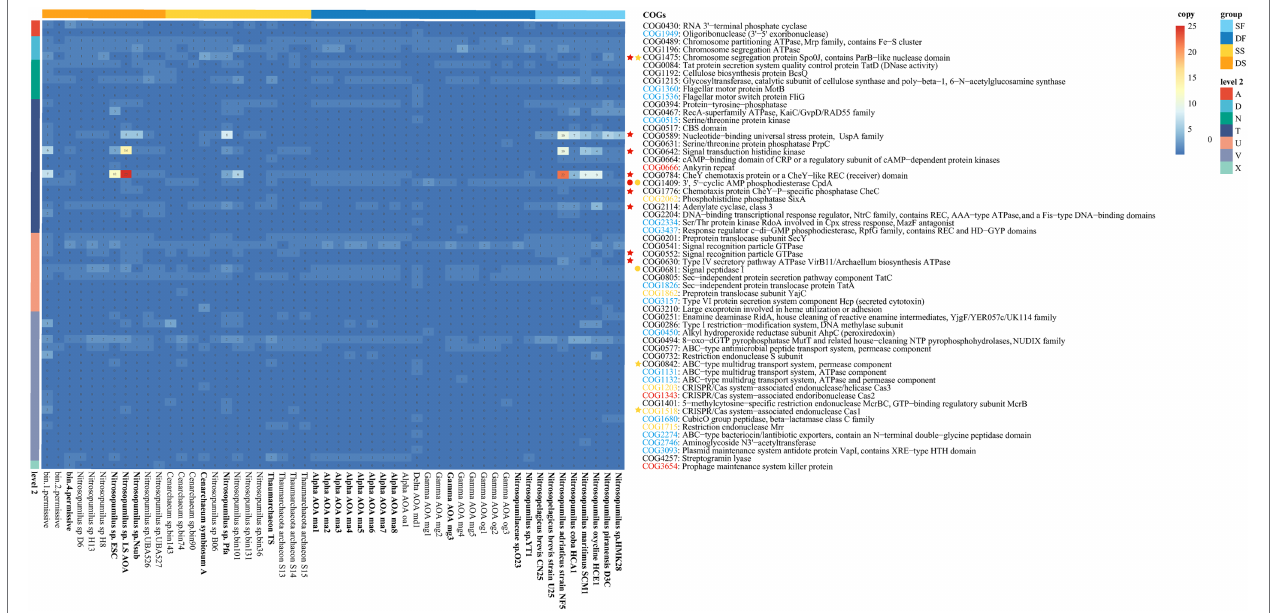
FIGURE 5 | Gene copies of sponge-enriched COG functional categories of sponge-associated and free-living Thaumarchaeota. Gene numbers are shown with different colors. The color of each gene on the right shows its prevalence in sponge-associated Thaumarchaeota: red, only in sponge-associated Thaumarchaeota; blue, significantly higher in sponge-associated Thaumarchaeota. The colors on top indicate the source: SF, shallow water (light blue); DF, deep sea (dark blue); SS, shallow-water sponge (yellow); and DS, deep-sea sponge (orange). The colored stars/circles before the COGs indicate the relatively enriched/deprived functions in all sponge-associated Thaumarchaeota (yellow star/circle) and deep-sea sponge-associated Thaumarchaeota (red star/circle) with >95% completeness (genome name shown in bold text) based on random forest analyses. The color of COG number represents the COGs that were only annotated in sponge (yellow), deep-sea sponge (red) and water